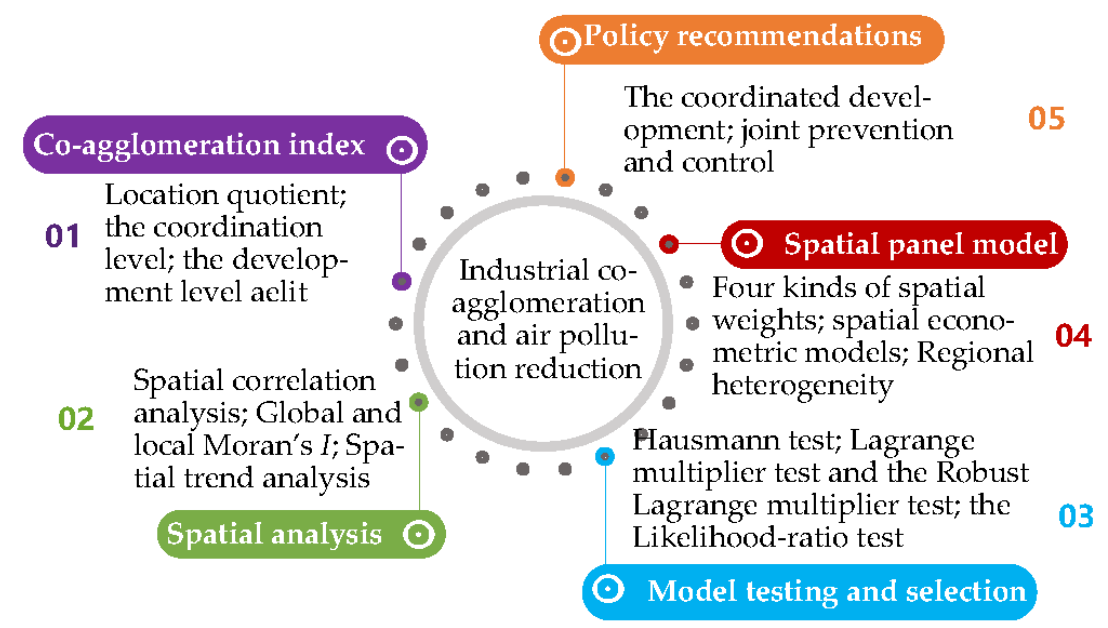
Figure 1. The research framework.